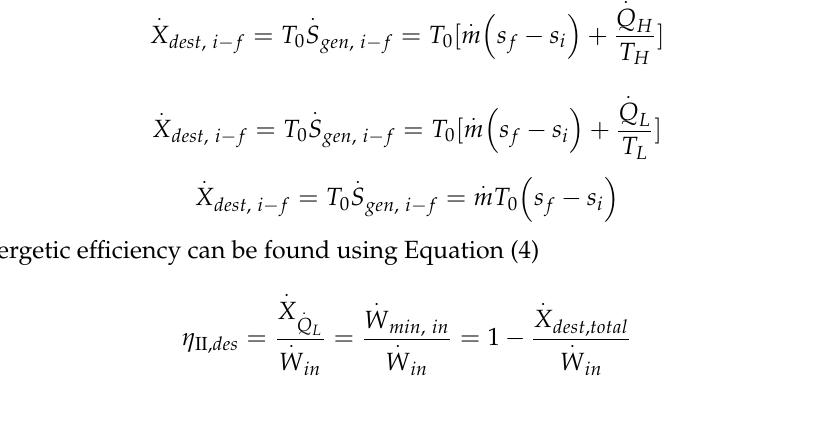
Figure 8. Water treatment Simulink model.